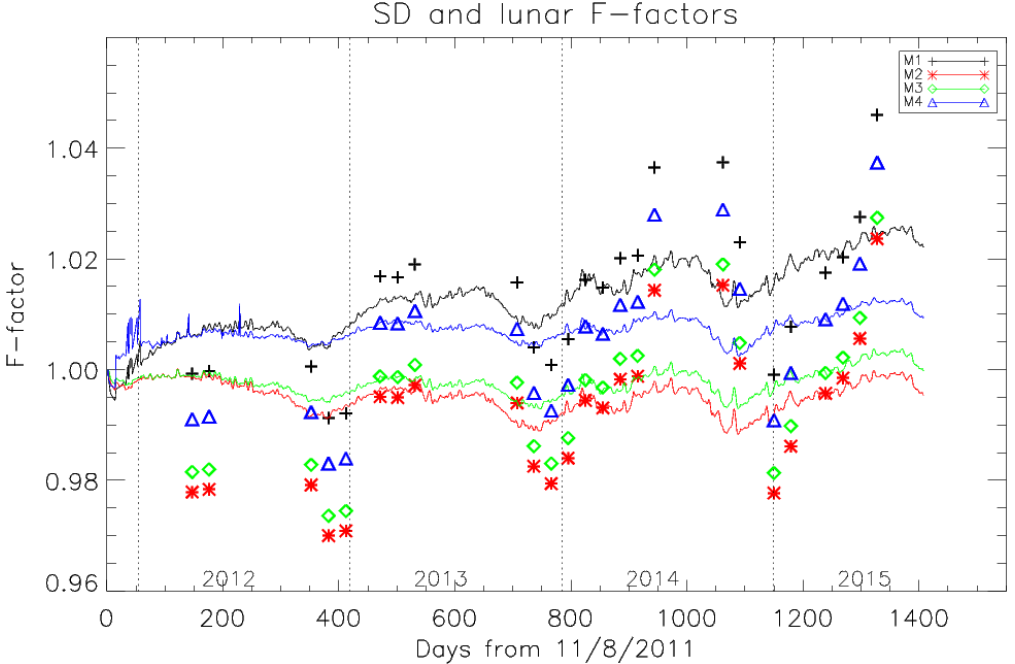
Figure 11. Normalized SD and MT-based lunar F-factors in bands M1 to M4. The lunar F-factors have been scaled to the SD F-factors with the best fitting scaling factors.